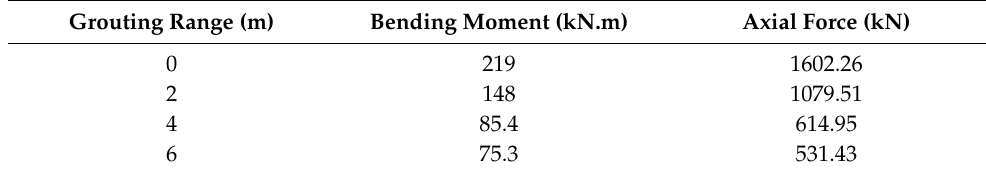
Table 4. Minimum and maximum internal forces of secondary lining with different grouting range. Grouting Range (m) Bending Moment (kN.m) Axial Force (kN) 0 219 1602.26 148